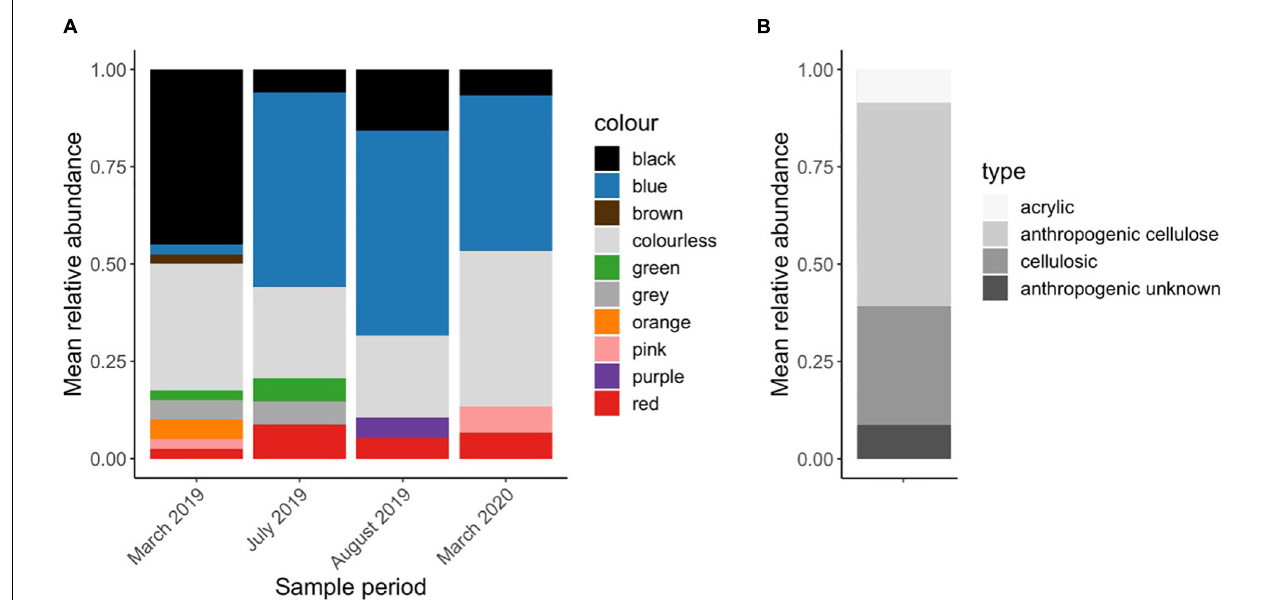
FIGURE 5 | Patterns of microfiber color and type in WWTP samples ( n = 3) across 4 sample periods. Results presented here are (A) the relative abundance of each color after blank subtractions in each sample period and (B) microfiber type as determined by chemical identification using Raman spectroscopy.